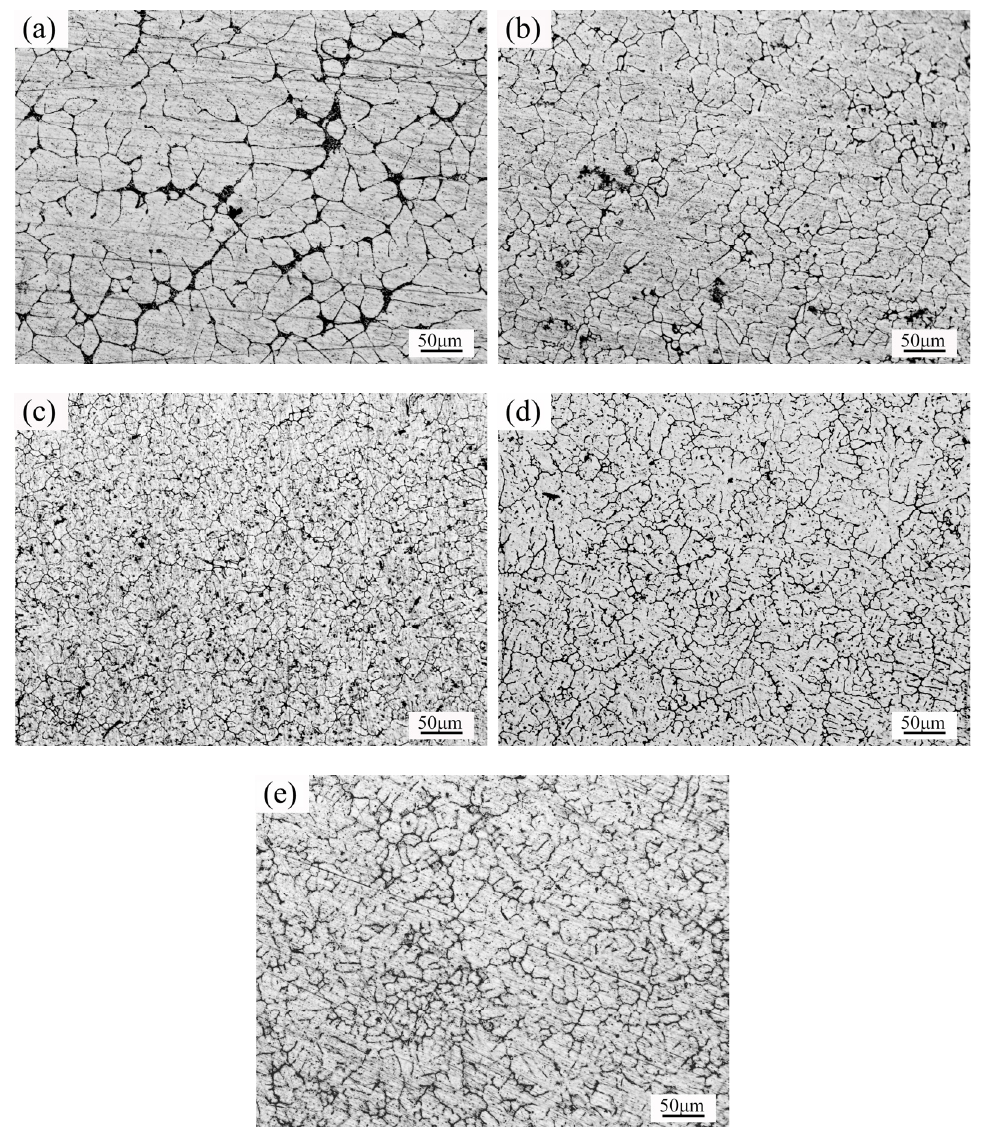
Figure 7. Metallographic photographs of the cover flange at different pouring temperatures: ( a ) 700 °C; ( b ) 710 °C; ( c ) 720 °C; ( d ) 730 °C; ( e ) 740 °C.